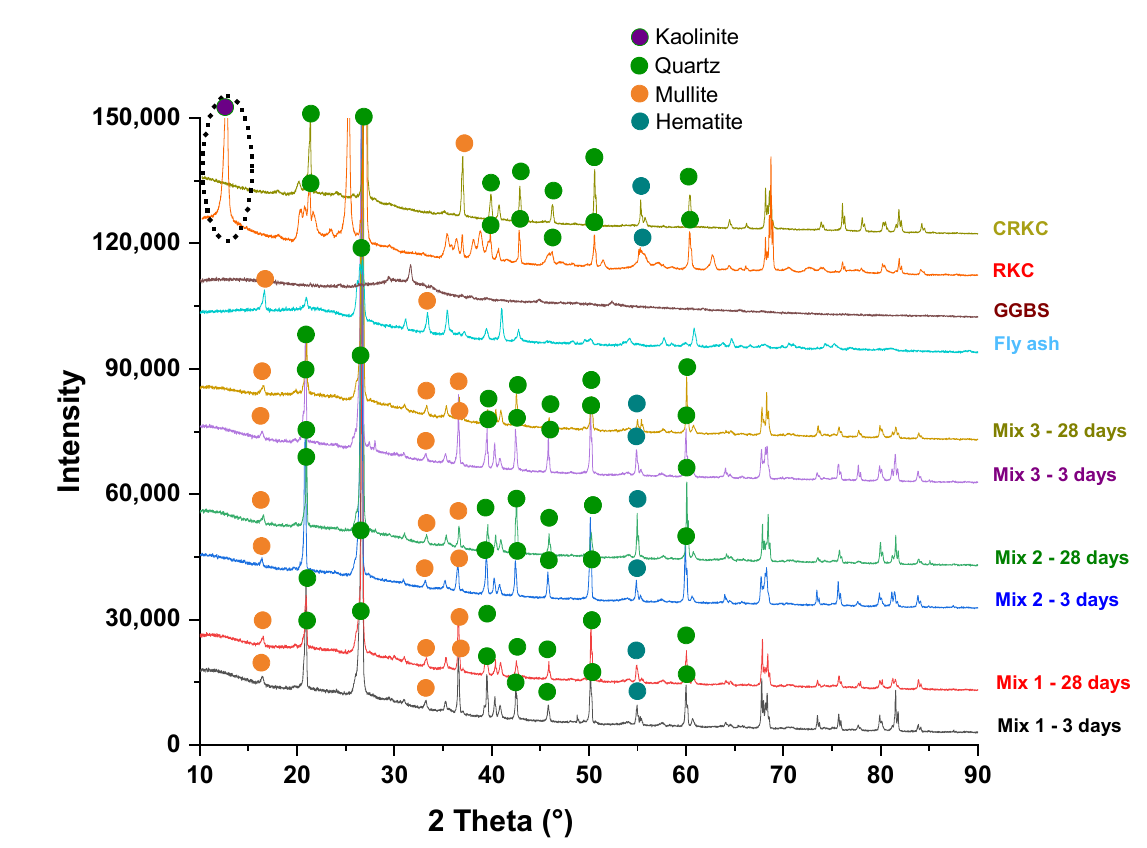
Figure 8. Integrated XRD patterns of developed geopolymer concrete samples.